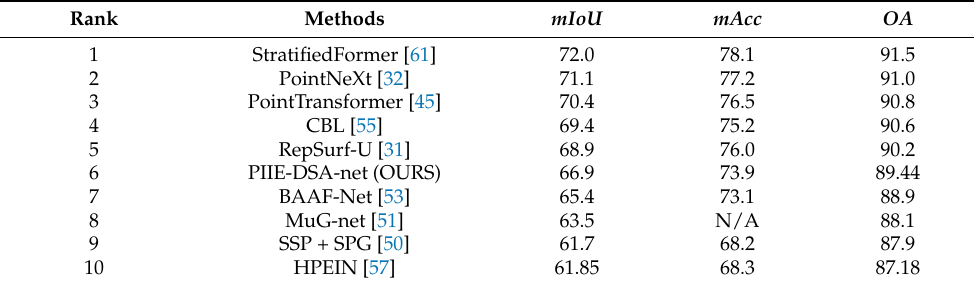
Table 4. Current overall TOP-10 ranking of Area5 experiments on the S3DIS dataset (%).